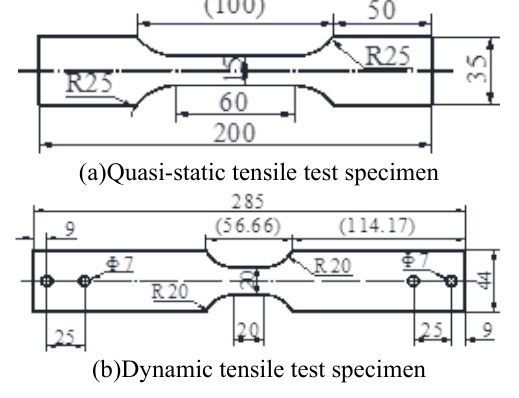
Figure 1. Size of specimens used in tensile tests.